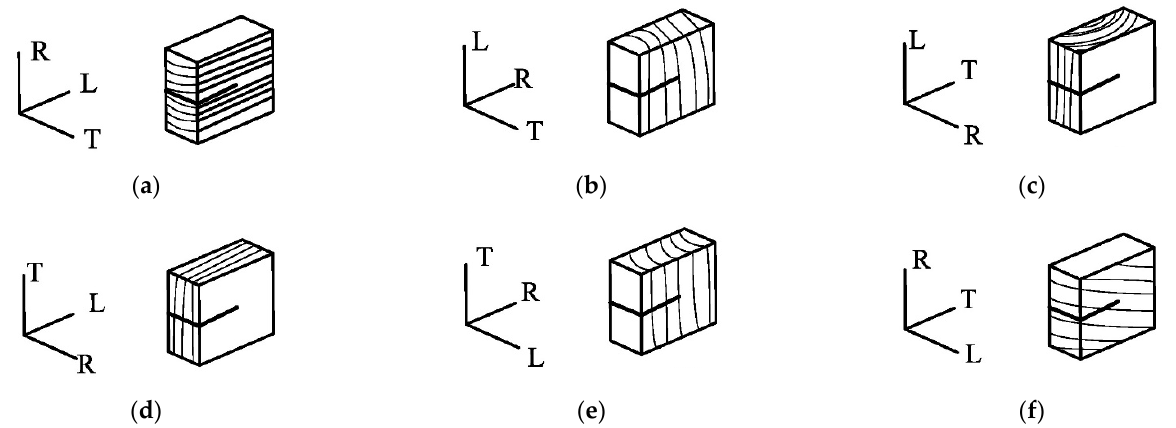
Figure 1. Possible crack propagation systems for wood ( a ) RL, ( b ) LR, ( c ) LT, ( d ) TL, ( e ) TR, and ( f ) TR.